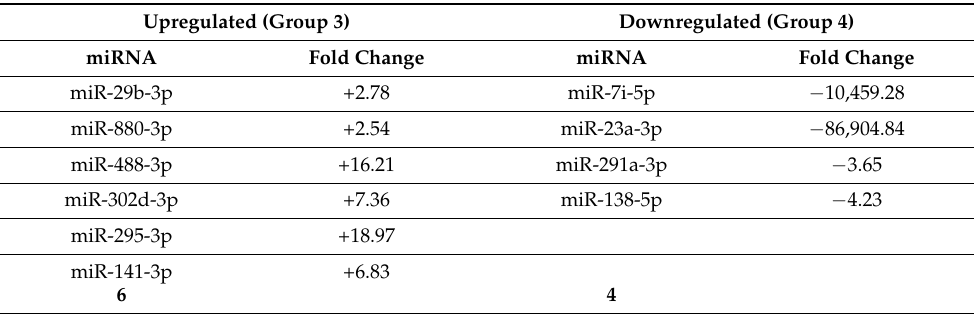
In bold, the number of miRNAs for each